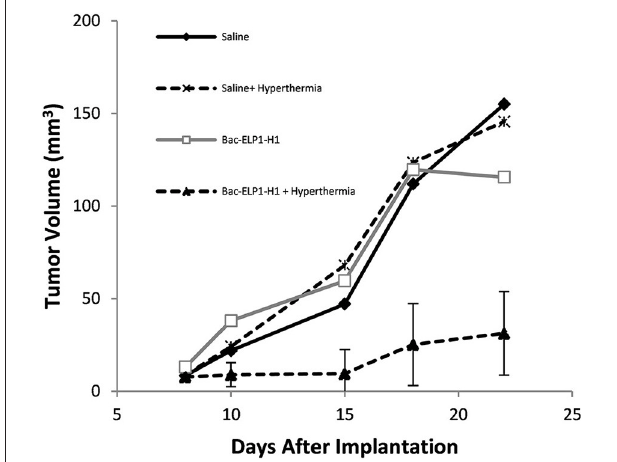
FIGURE 6 | Inhibition of Glioma Progression by the Thermally Targeted c-Myc Inhibitory Polypeptide. Sprague Dawley rats bearing intracerebral C6 tumors were treated with 4 daily IV injections of the Thermally Targeted c-Myc Inhibitory Polypeptide, with MRI monitoring of tumor volume. Average tumor volume for each treatment group. n = 6-8 animals per group; * , Tumor volume was significantly reduced compared to control tumors (one way ANOVA, post hoc